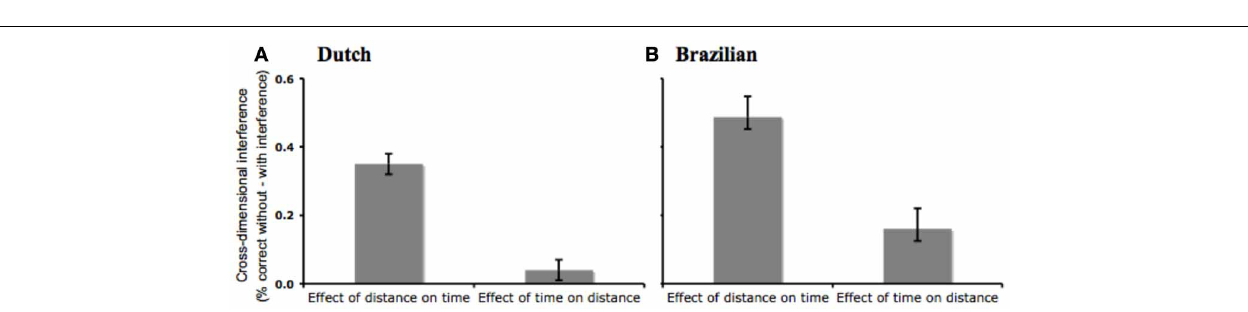
Frontiers in Psychology |